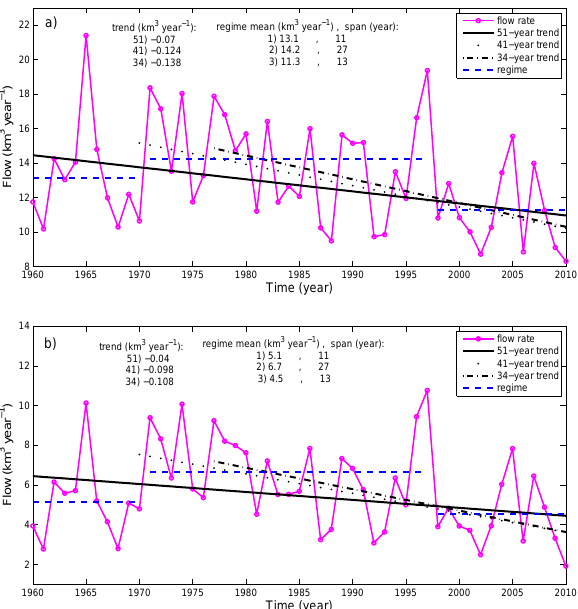
Fig. 4. Regime shifts and detected trends for three different analysis periods in (a) the Athabasca River near Athabasca and (b) the gauge contribution of the Athabasca River between the Athabasca and Windfall gauges. The trend levels for both time series are sig- nificant and decrease with the analysis periods moving towards the end of the study period, with their maximum (negative) trends over 1977–2010.